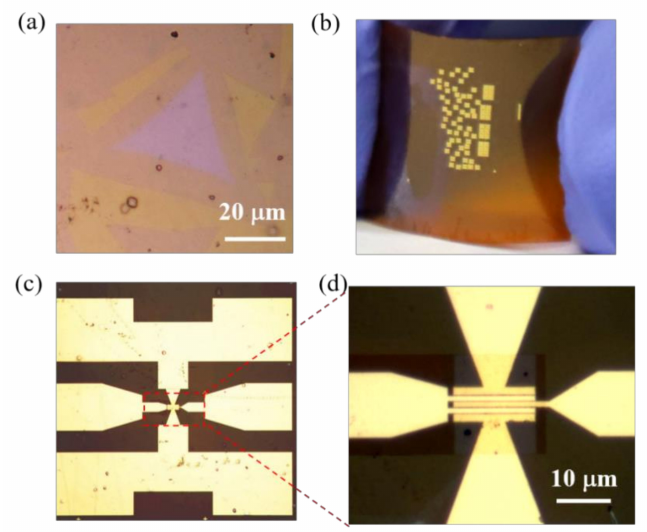
Figure 3. ( a ) The transferred bilayer MoS 2 on polyimide substrates. ( b ) Optical images of the fabricated flexible MoS 2 RF transistors. ( c , d ) Optical images of the flexible MoS 2 RF transistor with ground-signal-ground (GSG) structure showing excellent